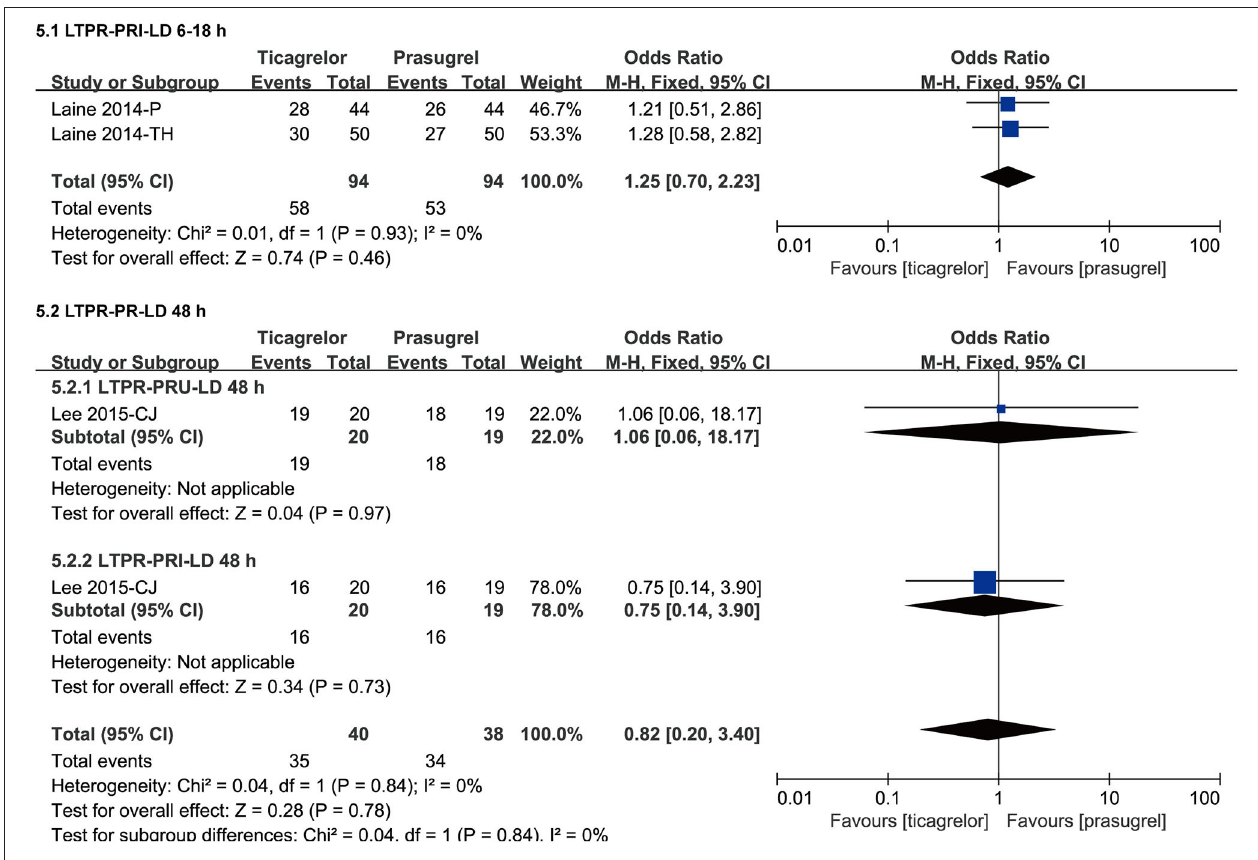
FIGURE 8 | Forest plots of meta-analysis results of LTPR after